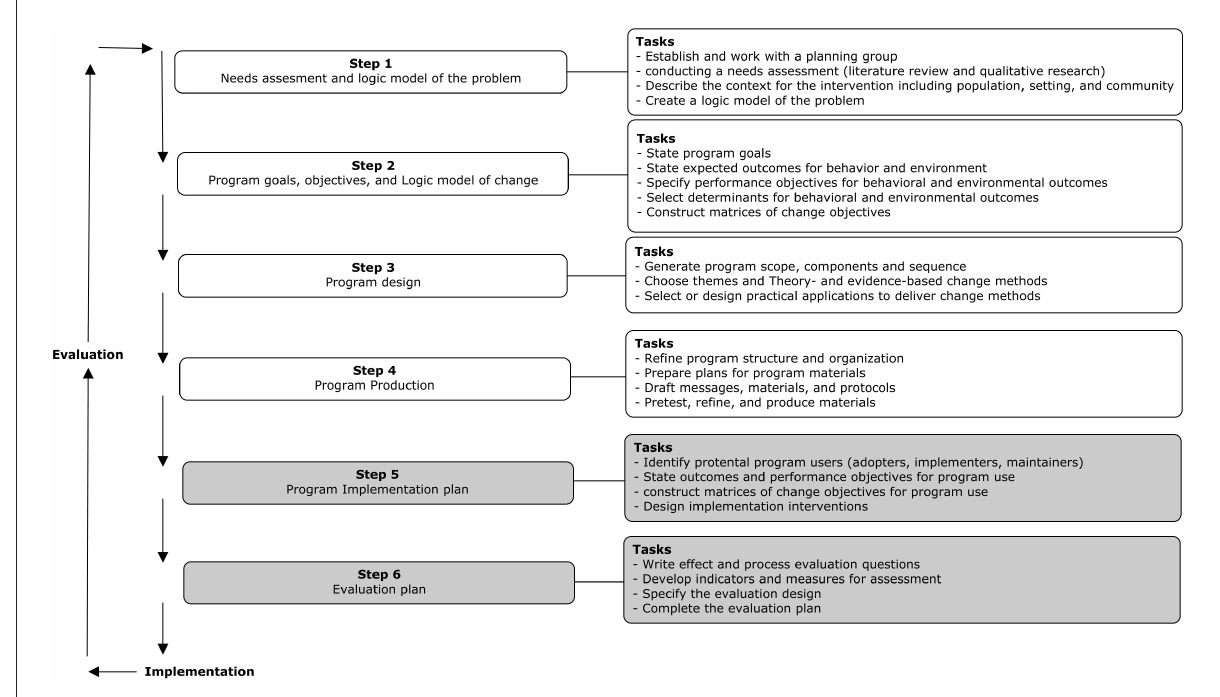
FIGURE1 Intervention mapping steps as adapted from Bartholomew et al.